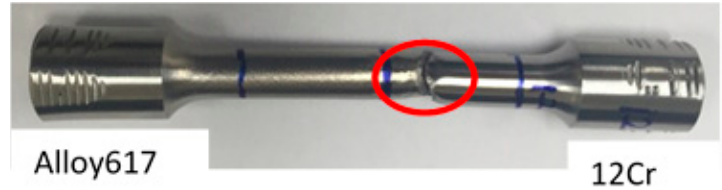
Figure 11. The fatigue tested specimen (failed at HAZ of 12Cr steel alloy).